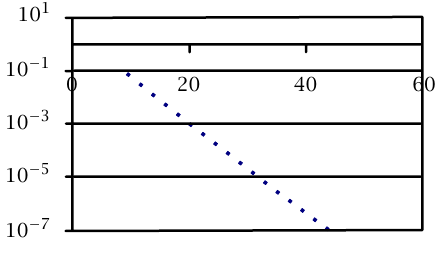
Figure 5.3 . Graph for odd n